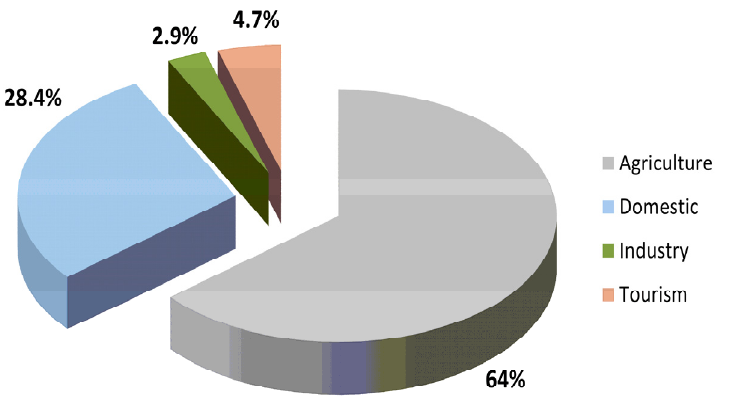
Figure 4. Diagram representation for water demand by sector: Agriculture, Domestic, Industry and Tourism Demand (Data: WDD statistics [15] and Cystat [31]).